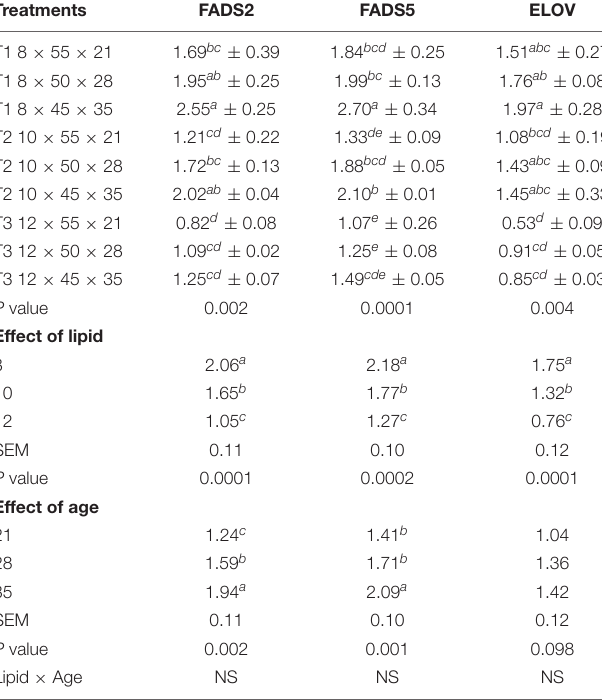
TABLE 5 | Effects of dietary lipid levels and age on the expression of lipolytic genes of C. magur. Treatments LPL PL BAL